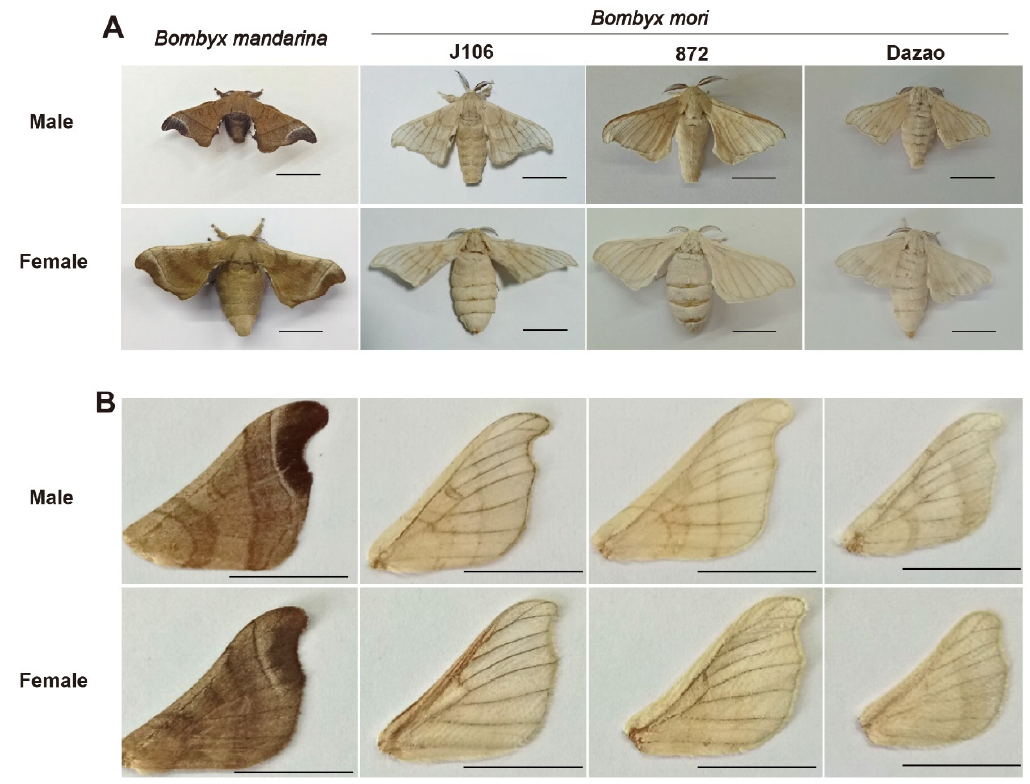
Figure 1. Morphologies of wild and domesticated silkworms and their forewings. ( A ) B. mandarina had black body color (left) and the B. mori were white (J106, 872, Dazao). ( B ) The color of the forewings was the same as the body color. Several measured characteristics of forewings were listed in Table 1 and plotted in Figures 2 and 3. Bars = 1 cm.